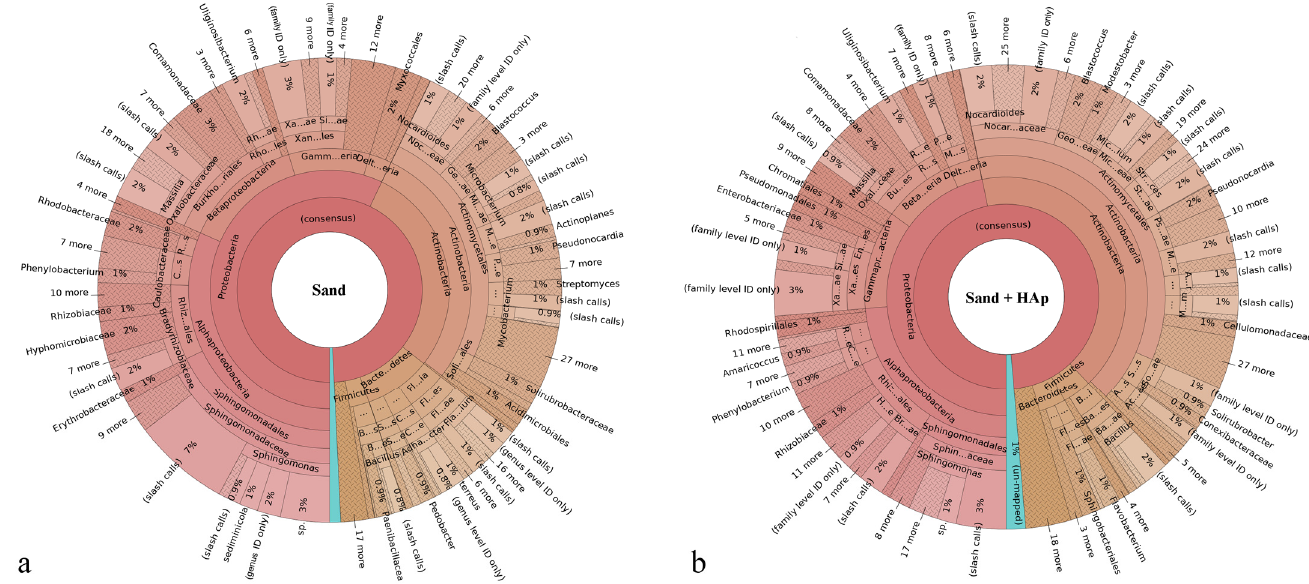
Figure 2. Consensus Krona plots representing the microbiome composition of the sandy soil before ( a ) and after ( b ) the treatment with HAp nanoparticles.